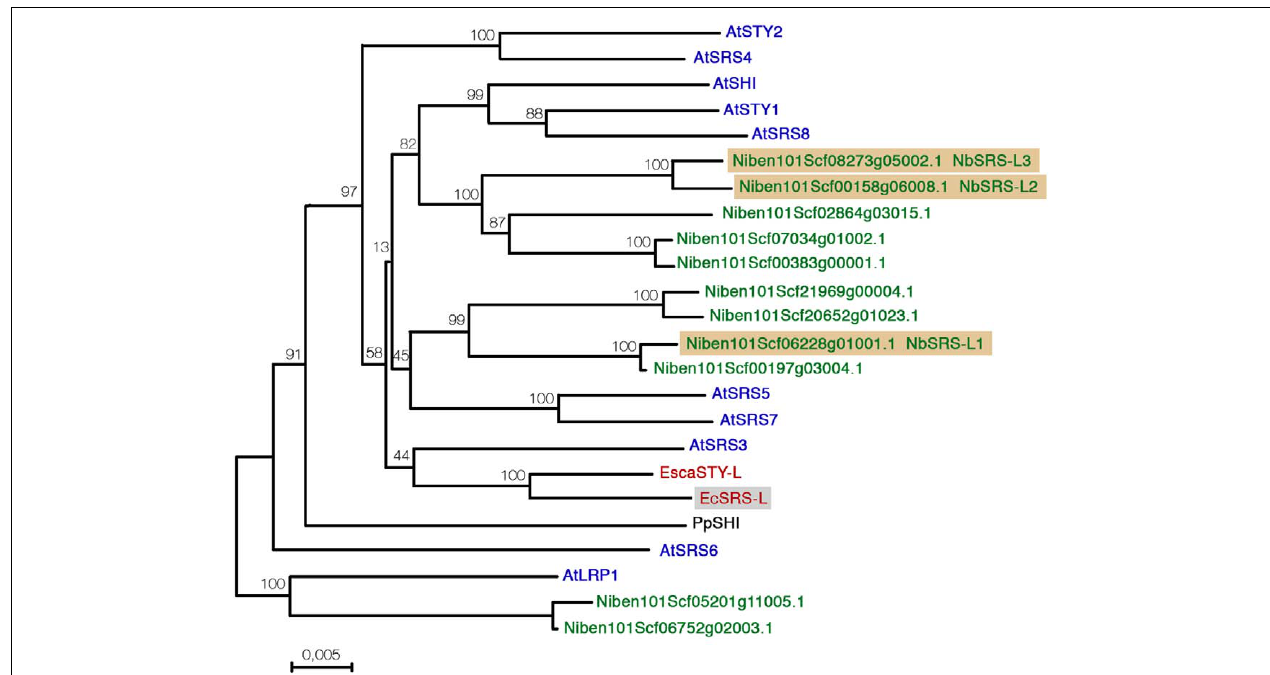
FIGURE 1 | Distance analysis between Nicotiana benthamiana , Eschscholzia californica , and Arabidopsis thaliana SHI/STY/SRS factors. Sequences were aligned with Muscle and the phylogenetic tree was generated using MEGA7 software using the Neighbor-Joining method. The optimal tree is shown. The percentage of replicate trees in which the associated protein sequences clustered together in the bootstrap test (2000 replicates) are shown next to the